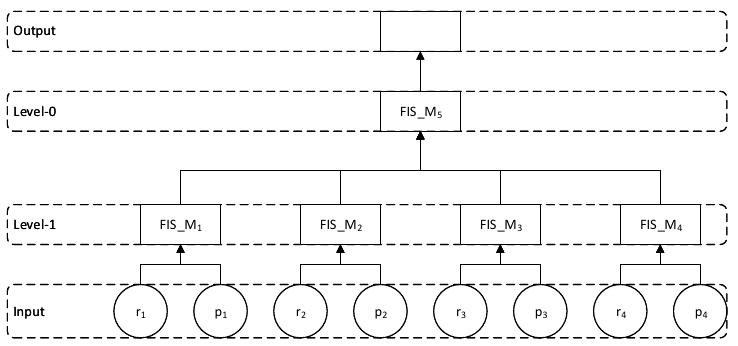
Figure 6. Model 1: basic hierarchical FIS.